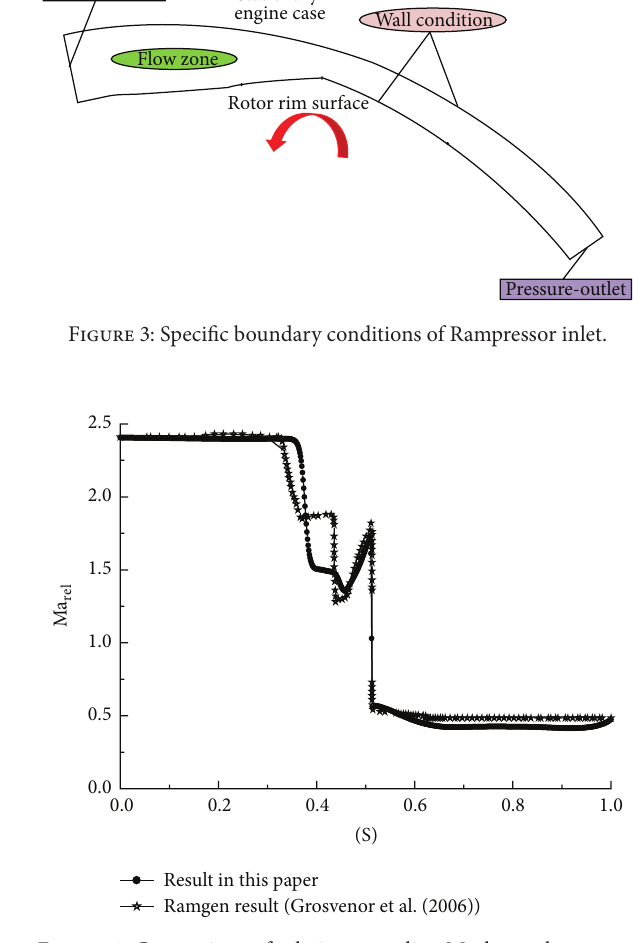
Figure 4: Comparison of relative centerline Mach number versus normalized streamwise distance (S) between result in this paper and result in